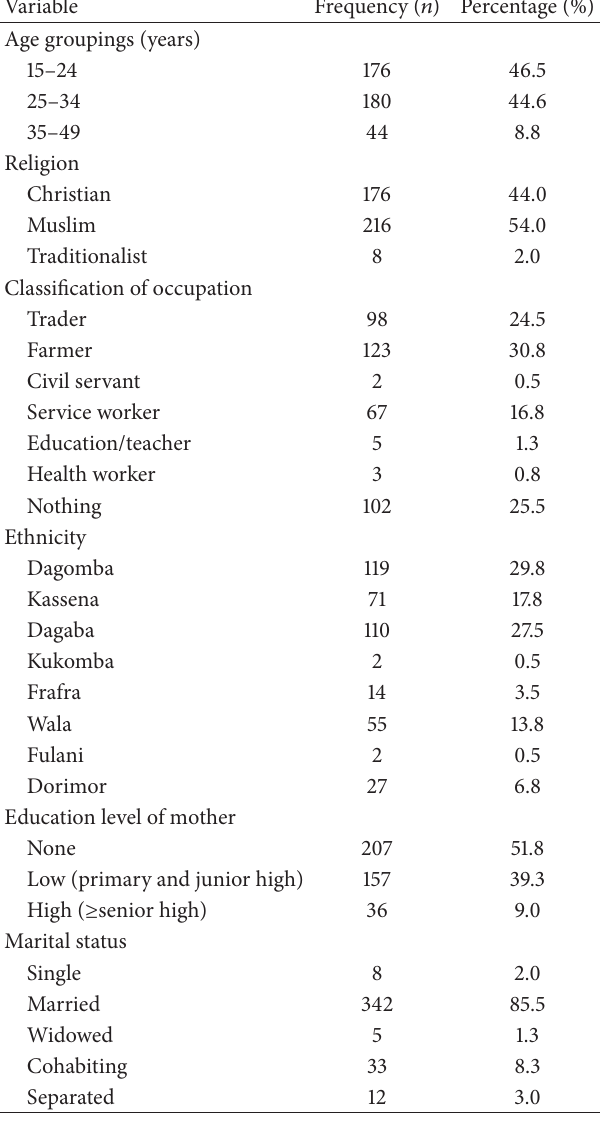
Table 1: Sample characteristics ( 𝑁 = 400